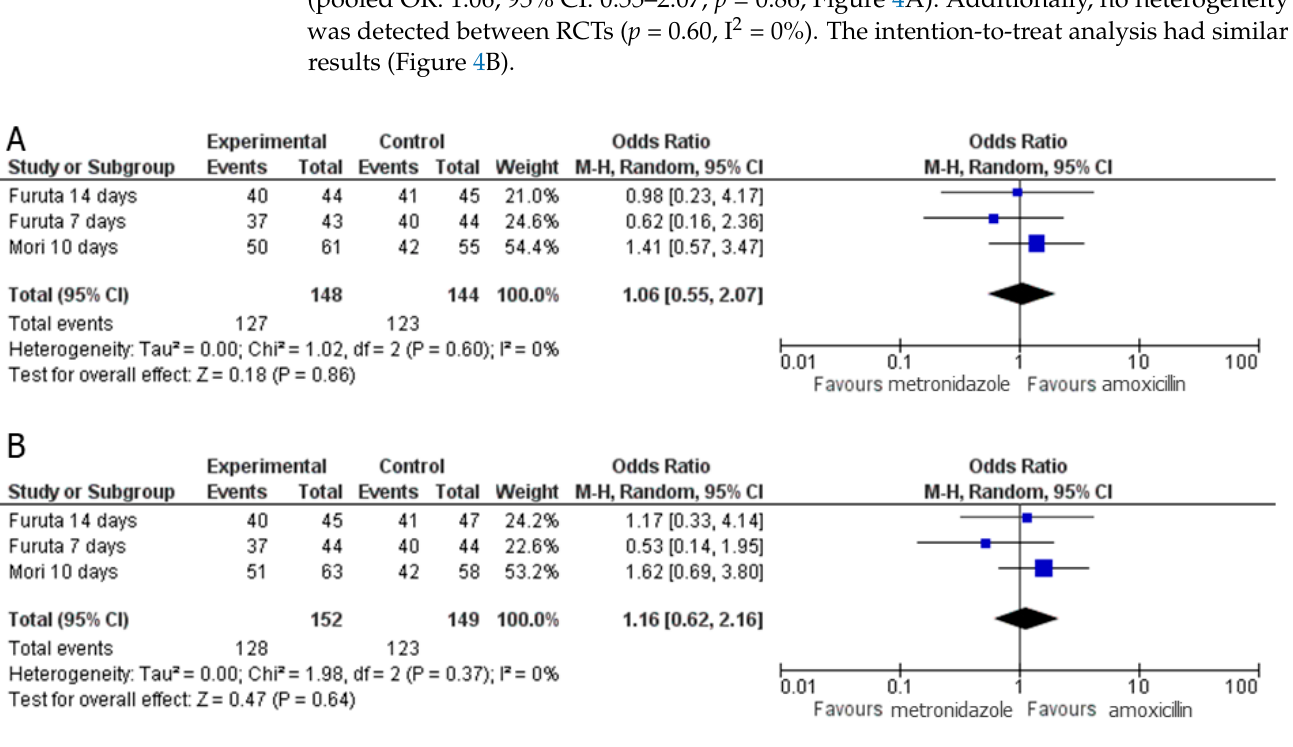
Figure 4. Forest plot of the pooled odds ratio (OR) with 95% confidence intervals (CI) of eradication failure when using regimens of PPI–sitafloxacin–amoxicillin and PPI–sitafloxacin–metronidazole. ( A ) Per-protocol analysis. ( B ) Intention-to- treat analysis.